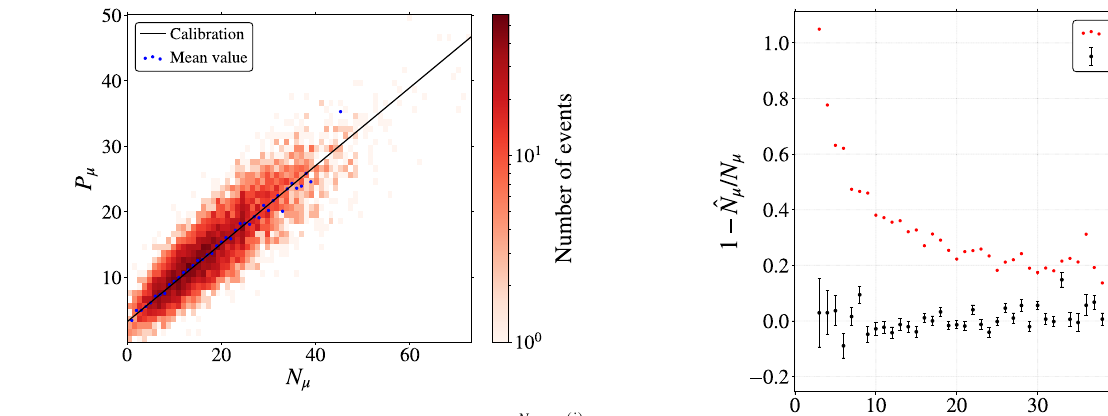
Fig. 7 Calibration of the relationship between N μ = (cid:7) N S P μ = P ( i ) μ using proton induced air showers i = 0